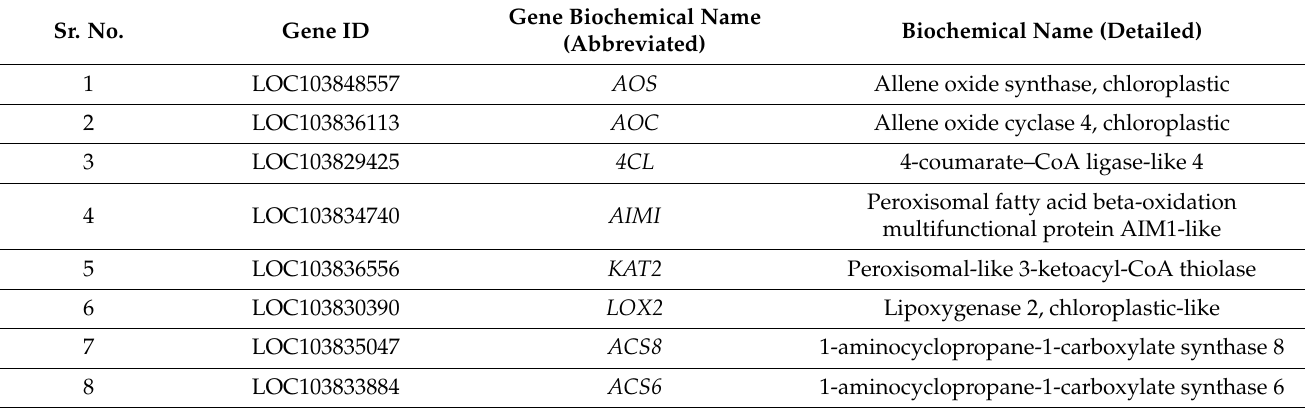
Table 1. Key genes associated with the JA, SA, and ET pathways of B. rapa . Sr.